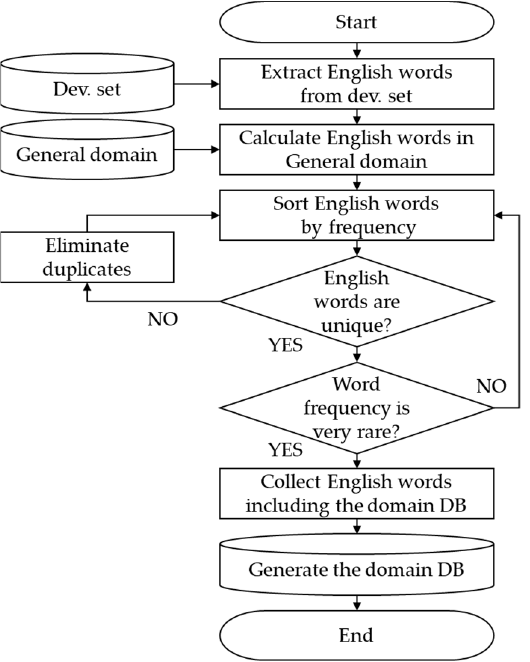
Figure 6. Block diagram of the sentences containing more than two English words. Dev. set, devel- opment set; DB, database.